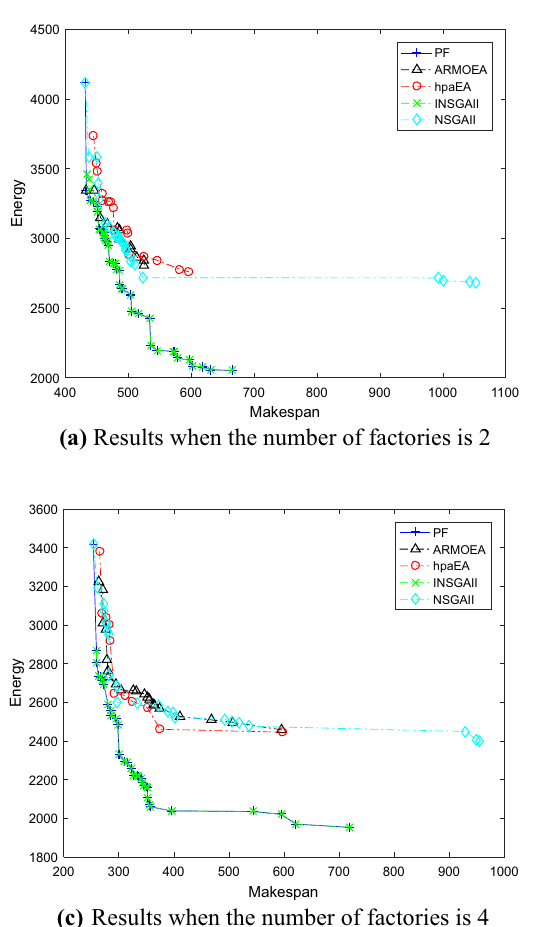
of effective search operators. More and more realistic